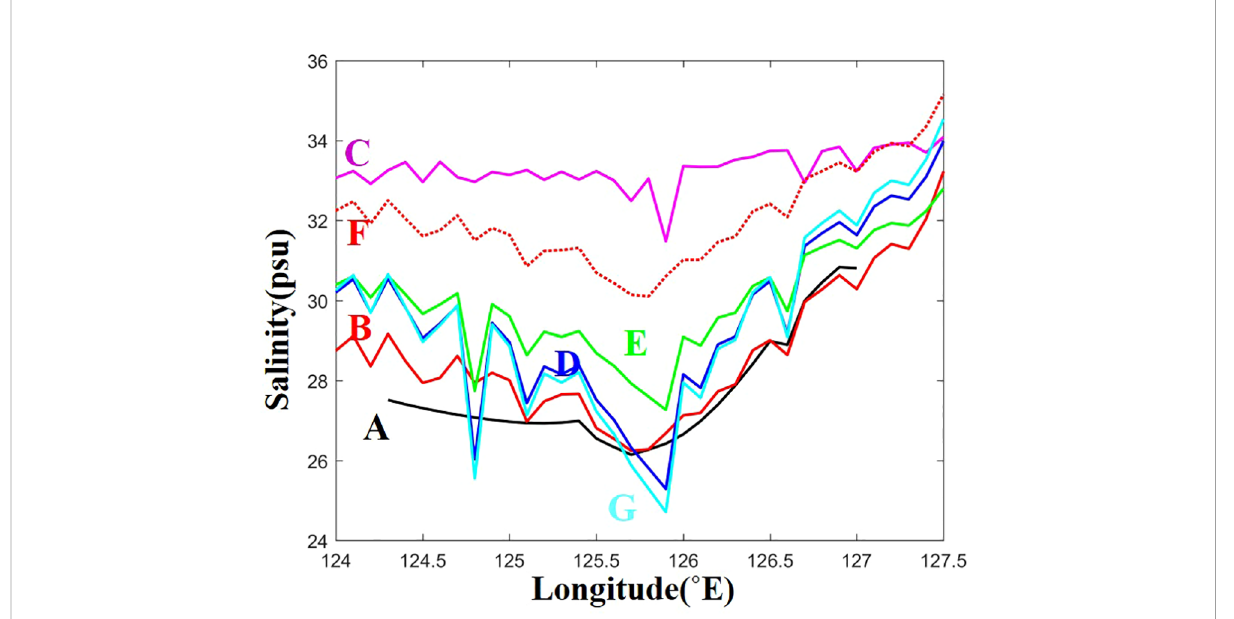
FIGURE 7 Longitudinal transects of in situ (A) and satellite-derived salinities obtained along 33° N during the 2016 summer cruise (longitudinal lines are shown in (A) . (A) In situ salinity and (B) results of the proposed two-step approach (Eq. 4) and methods of (C) Binding and Bowers (2003), (D) Ahn et al. (2008), (E) Sasaki et al. (2008), (F) Son et al. (2012), and (G) Bai et al. (2013). Data were averaged over a 4-day cruise (16 – 19 August